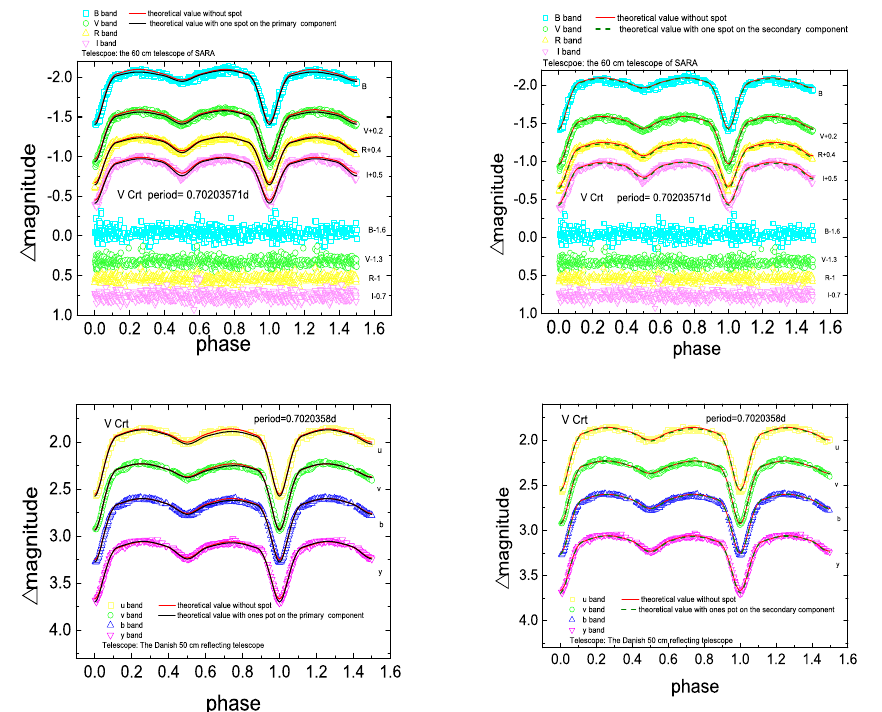
Figure 2. The theoretical and observational light curves of V Crt, where observations are colored points; model light curves are solid